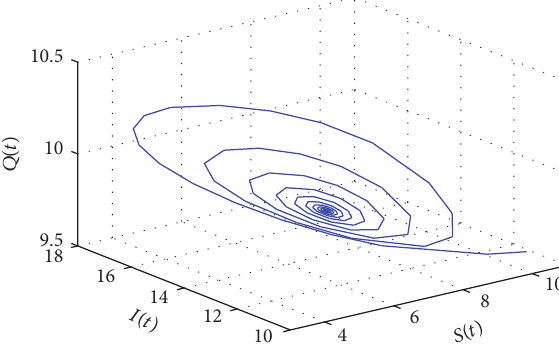
Figure 14: The phase plot of 𝑆 , 𝐼 , and 𝑄 when 𝜏 1 = 0.785 < 0.8903 = 𝜏 󸀠 10 and 𝜏 2 = 1.05 .